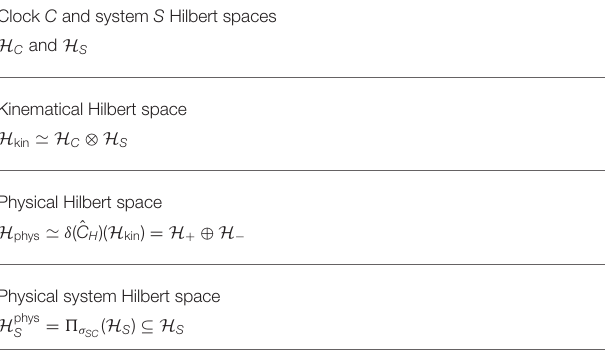
TABLE 2 | Summary of different Hilbert spaces. Clock C and system S Hilbert